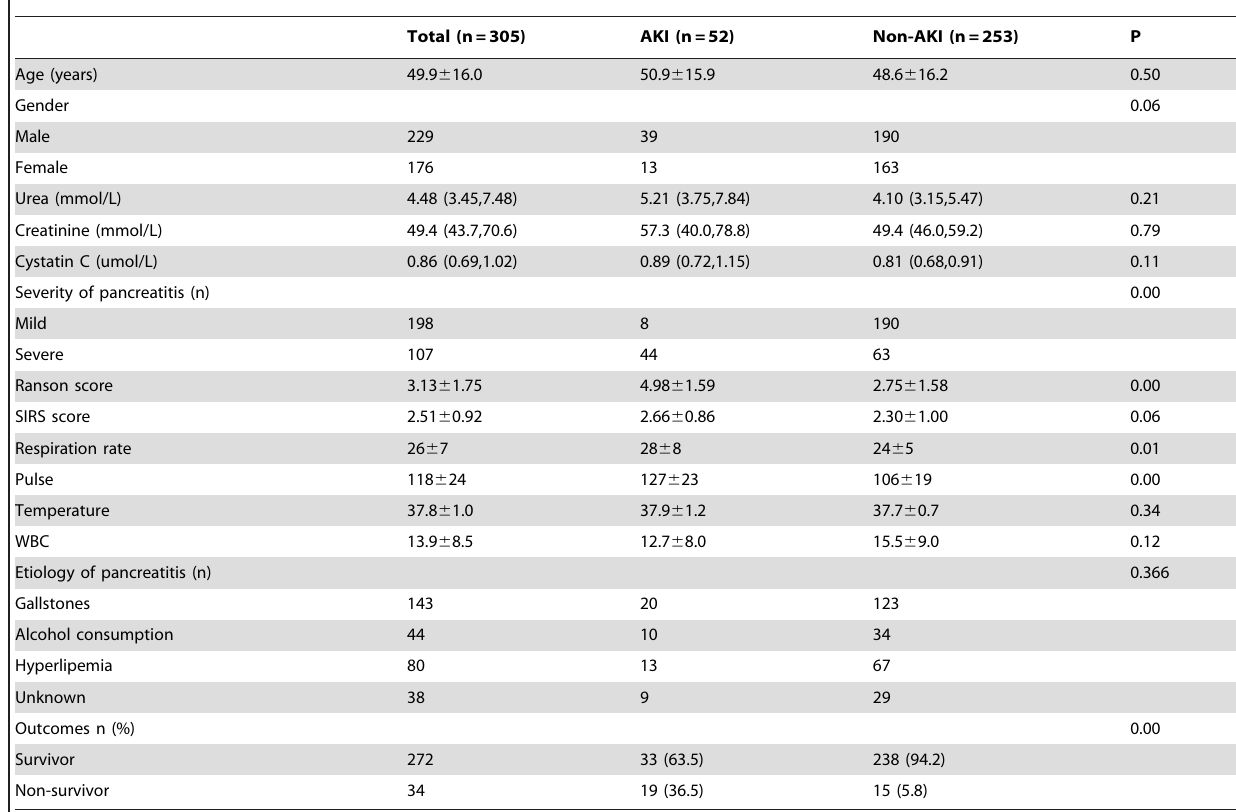
Table 1. Initial characteristics of 305 patients with acute